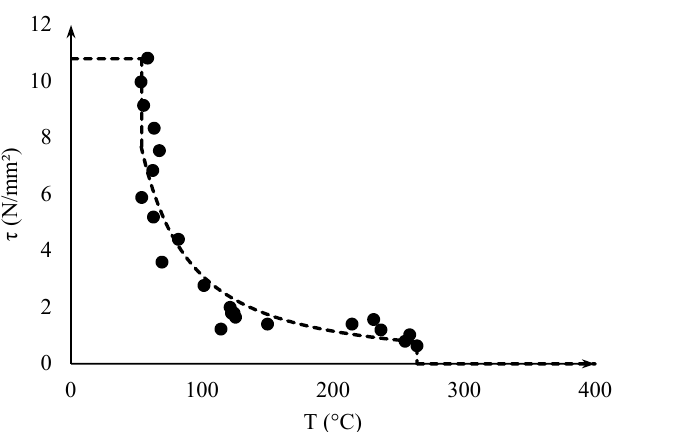
Figure 10. Bond stress vs. temperature relationship for Adhesive-3 according to EAD 330087-00-0601 [15].